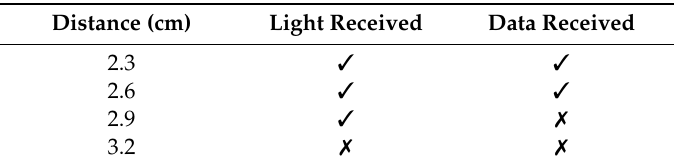
Table 1. Distance tests results.